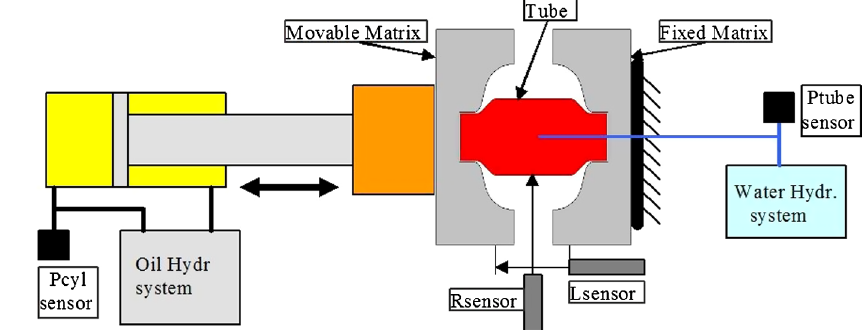
FIG. 11. Setup of the hydroforming machine at DESY.